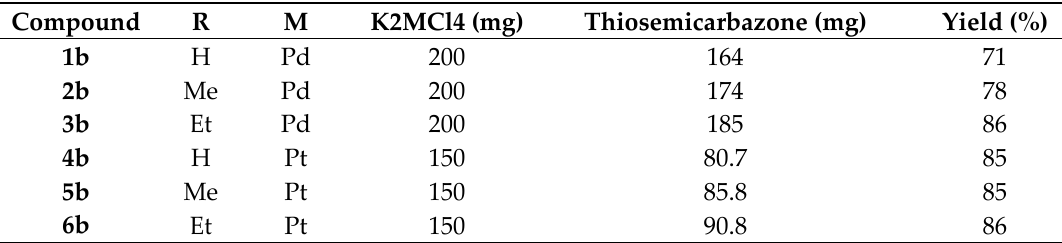
Table 2. Quantities of reagents